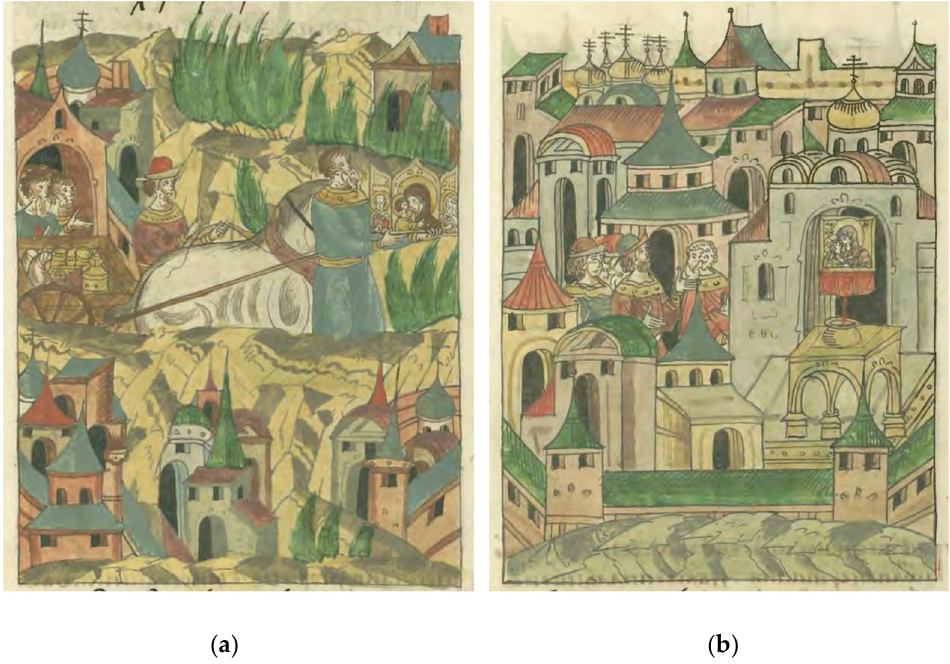
Figure 5. Magical powers of religious images. ( a ) Procession of a miracle-working icon in Moscow, 1413; ( b ) an icon of the Mother of God bleeding in Novgorod, 1411. The Illustrated Chronicle of Ivan the Terrible , Osterman Volume II . Library of the Russian Academy of Sciences.